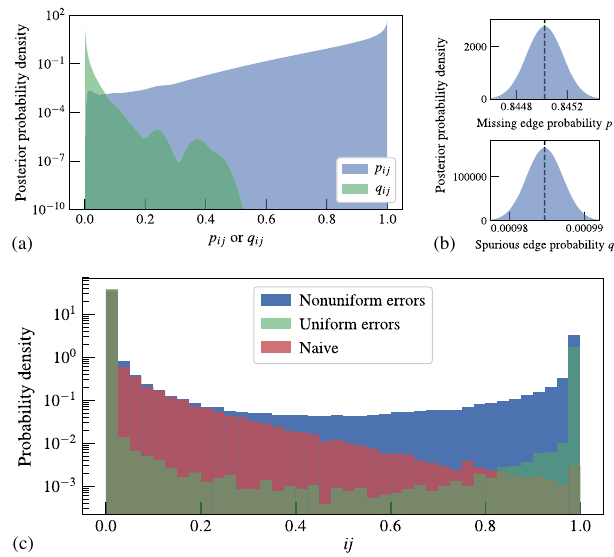
FIG. 15. Inferred uncertainties for the human connectome. (a) Posterior distribution of p ij and q ij , using the nonuniform model. (b) Posterior distribution of p and q , using the uniform model. (c) Distribution of posterior marginal edge probabilities π ij , according to both model variants, as well as the naive estimate ˜ π ij ¼ x ij =n ij